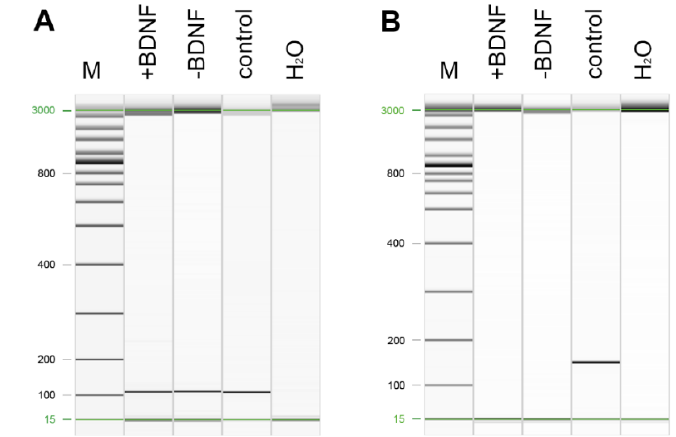
Figure 4. RT-PCR of TrkB ( A ) and SOST ( B ). TrkB PCR product was found in MLO-Y4 treated with and without BDNF as well as in the positive control (murine brain) at the appropriate height ( A ). SOST was not detected in MLO-Y4 ( B ). Messenger RNA of murine bone was used as positive control where a PCR product of appropriate height was found. M standard marker [bp]. H 2 O control run without cDNA template.